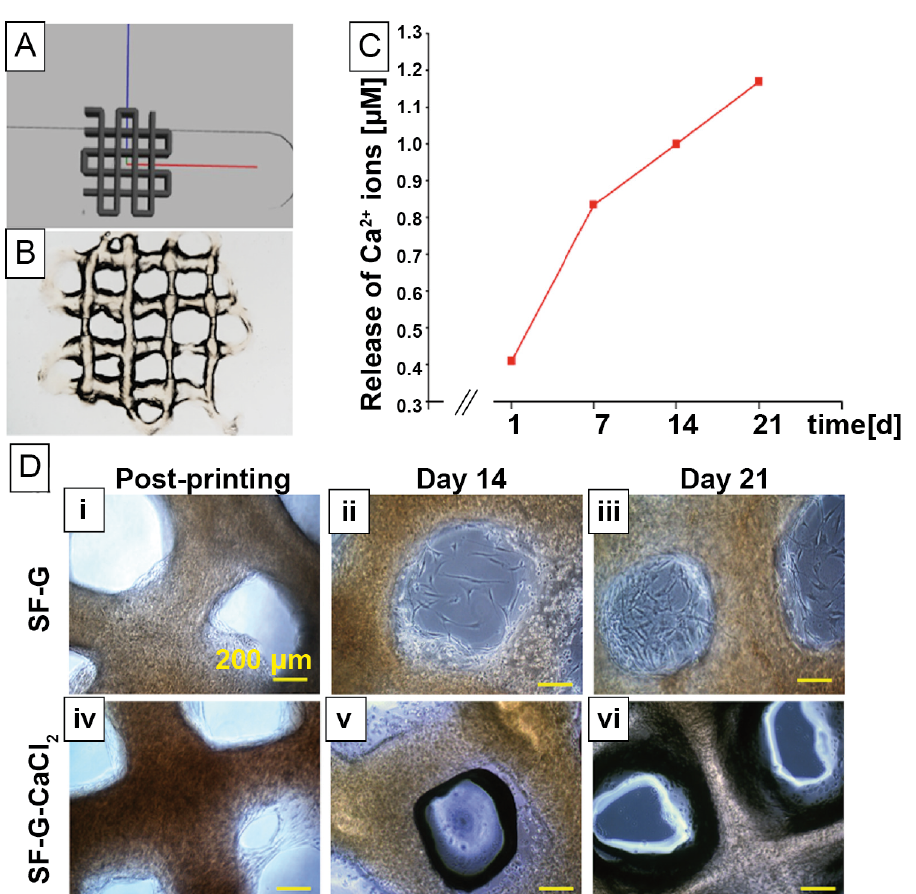
Figure 5. ( A ) CAD sketch of a Bombyx mori silk fibroin/gelatine construct and ( B ) its 3D dispense plotted result. ( C ) Release profile of calcium ions from Bombyx mori silk fibroin/gelatine hydrogels, loaded with calcium chloride. ( D ) Light microscopy images of unloaded ( i – iii ) and loaded ( iv – vi ) silk/gelatine hydrogels with human mesenchymal stem cells post-printing ( i , iv ), after 14 ( ii , v ) and 21 days ( iii , vi ). Unloaded scaffolds showed cells present in both the construct and in pores, whereas, in the loaded construct, cells remained in the strands. SF = silk fibroin, G = gelatine. Reprinted and adopted with permission from ref. [122]. Copyright 2019 American Chemical